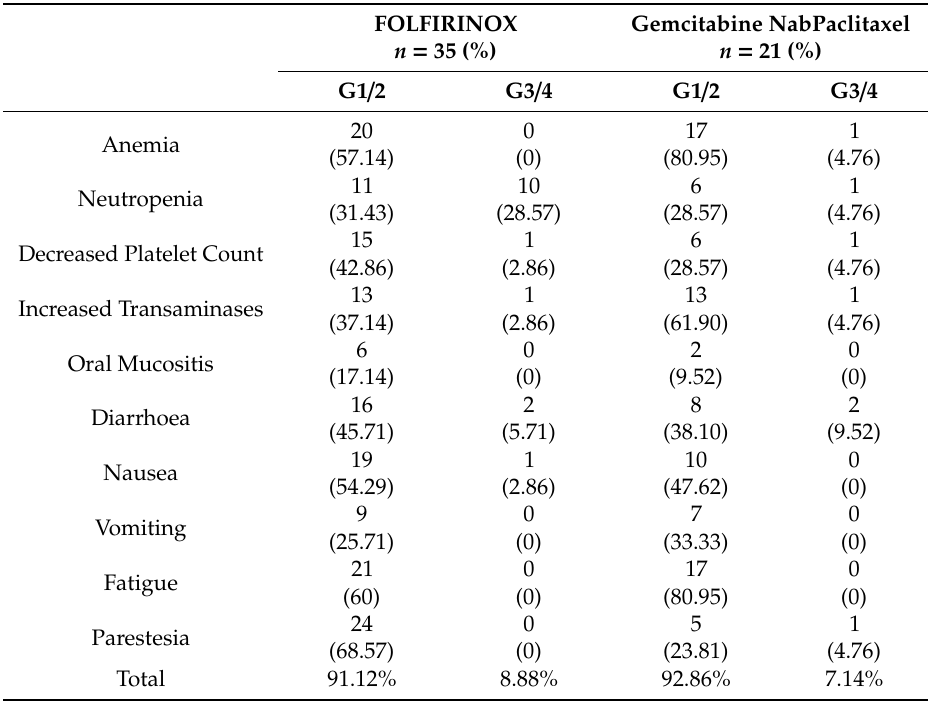
Table 3. Toxicities of the